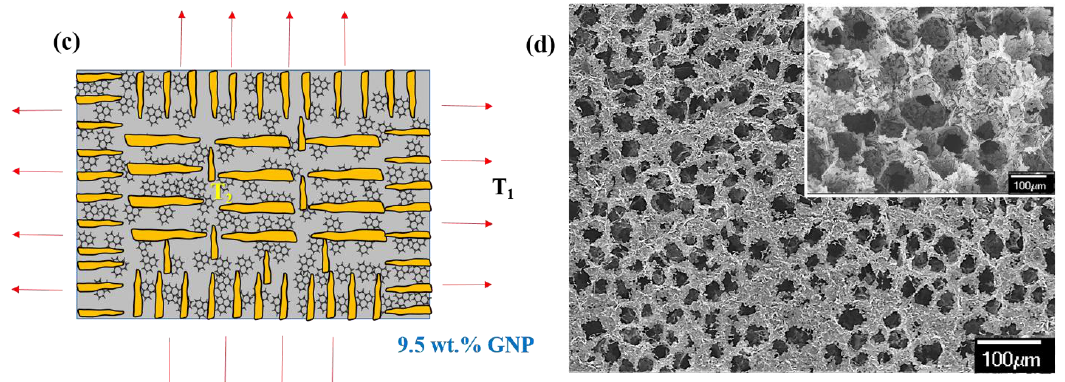
Figure 6. ( a , c ) Schematic representing the influence of free energy of the slurry system on the length and diameter of the freezing ice crystal; ( b ) SEM image of 3D GNP foam with 8 wt.% GNP; and ( d ) SEM image of 3D GNP foam with 9.5 wt.% GNP (3D foam made in a circular Al mold of 20 mm length, 10 mm diameter, and 0.16 mm thick) .